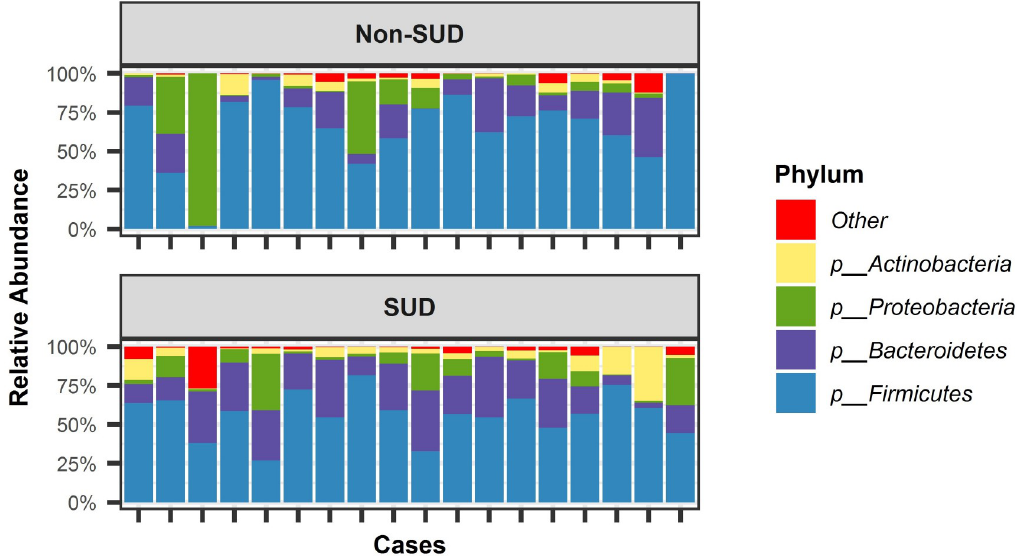
Fig 1. Depiction of four most prevalent bacteria detected per case and per SUD group. Welch’s non-parametric t-test shows that those groups are significantly different in their B:F population ratios.